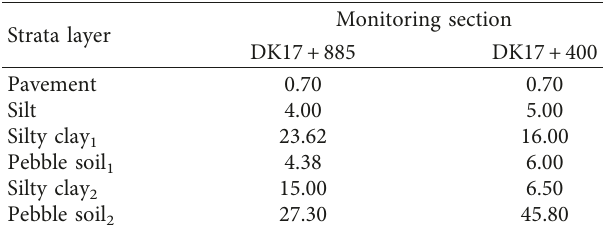
Table 2: The thickness of the strata layer at different monitoring sections (unit: